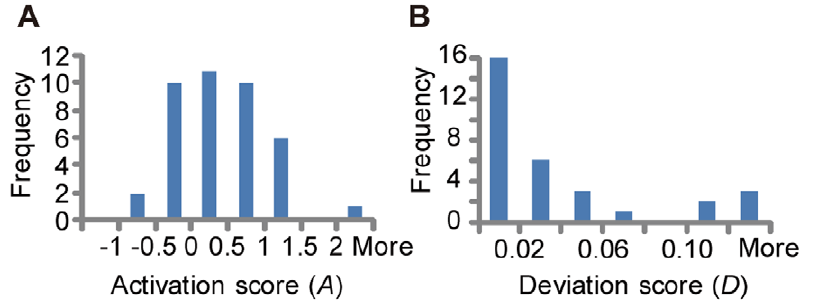
Figure 2. Distinct signal properties regarding WT and Y992F cells. A . The differential phosphorylation status between WT and Y992F cells. The distribution of the activation score ( A ) of each protein, which indicates the fold-change of phosphorylation amount of Y992F versus that of WT. B . The differential phosphorylation dynamics between WT and Y992F cells. The distribution of deviation score ( D ) of each protein, which indicates the deviation of the phosphorylation pattern.